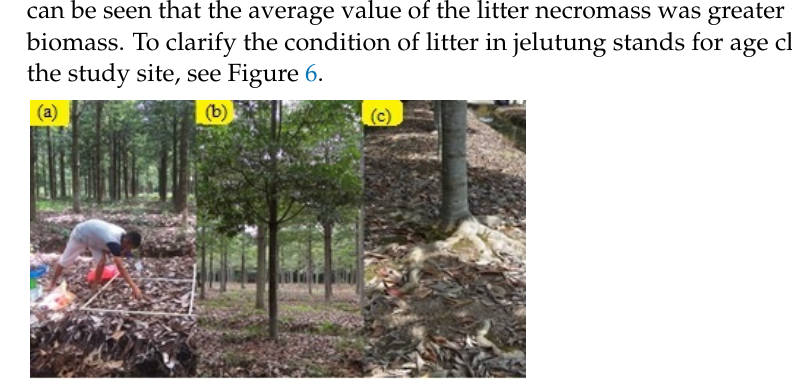
Figure 6. The condition of litter in jelutung stands for age classes I, II, and III. Remarks: (a) solid litter in age class I; ( b ) moderate litter in age class II; and (c) rare litter in age class